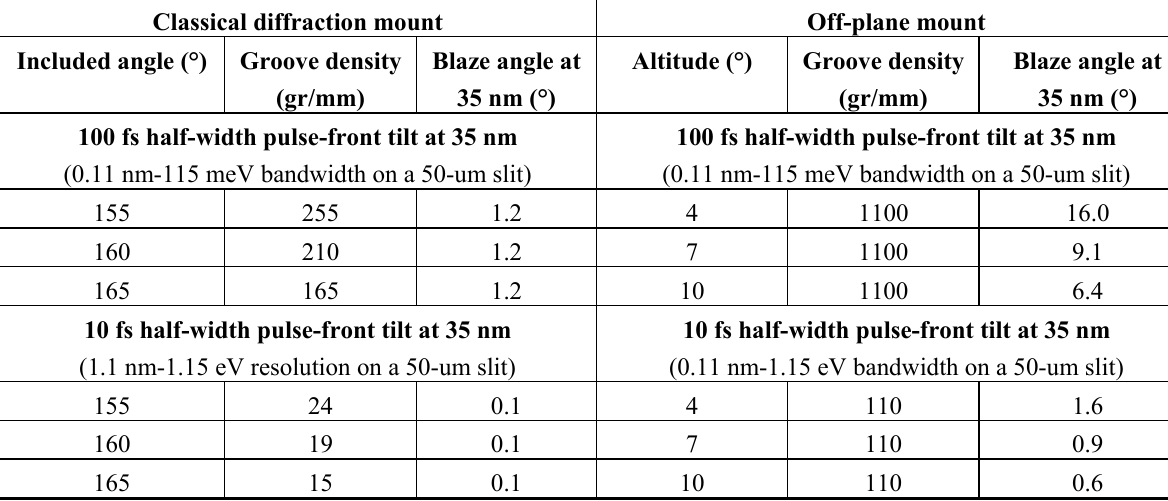
Classical diffraction